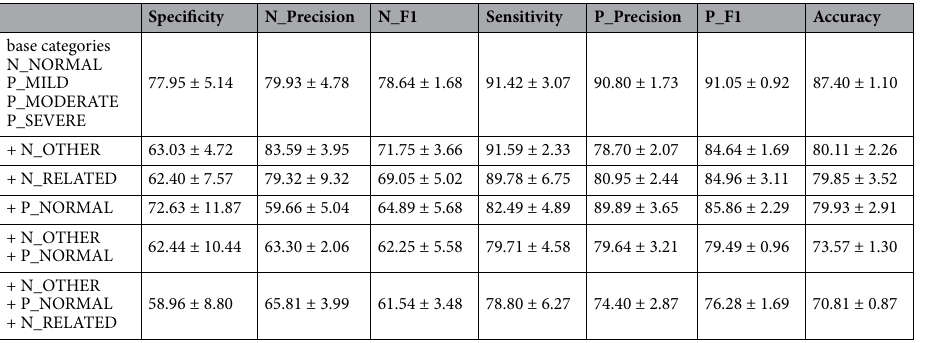
Table 5. Performance on different COVID-SC testing setups: baseline experiment and, in following rows, the effect on performance of adding other